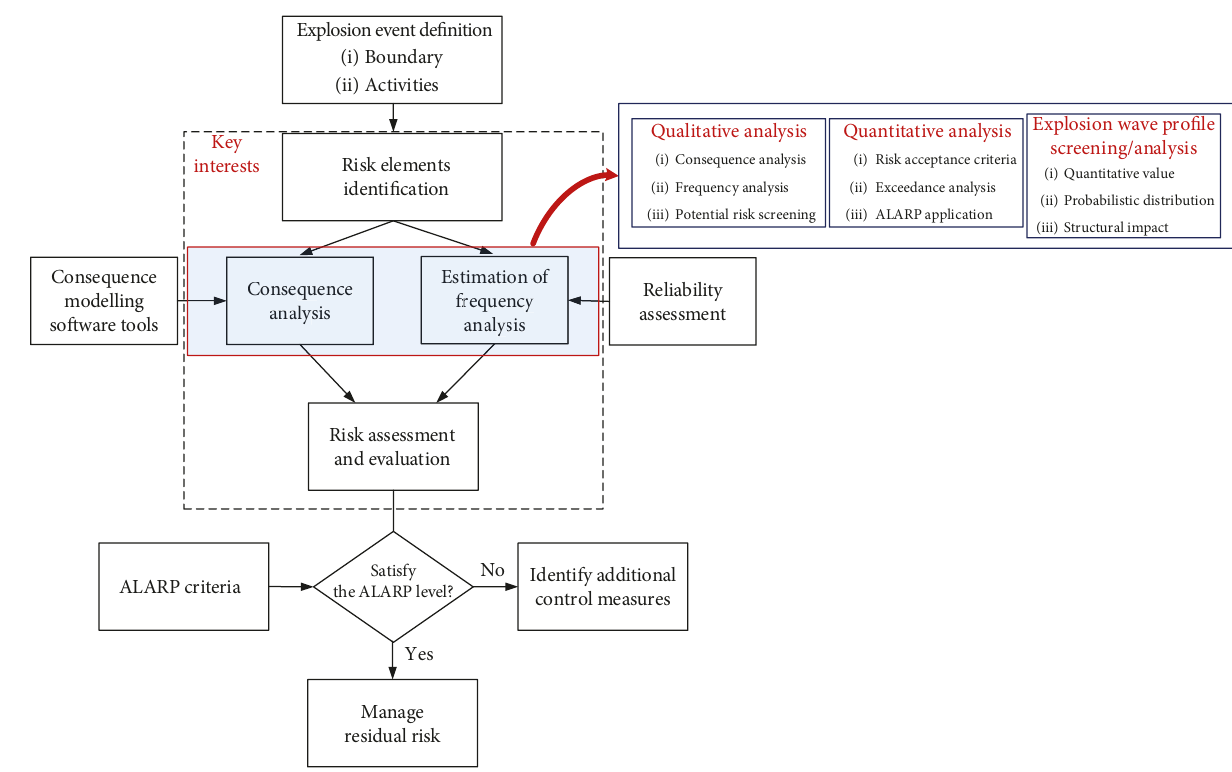
Figure 1: The fl owchart of the explosion risk assessment